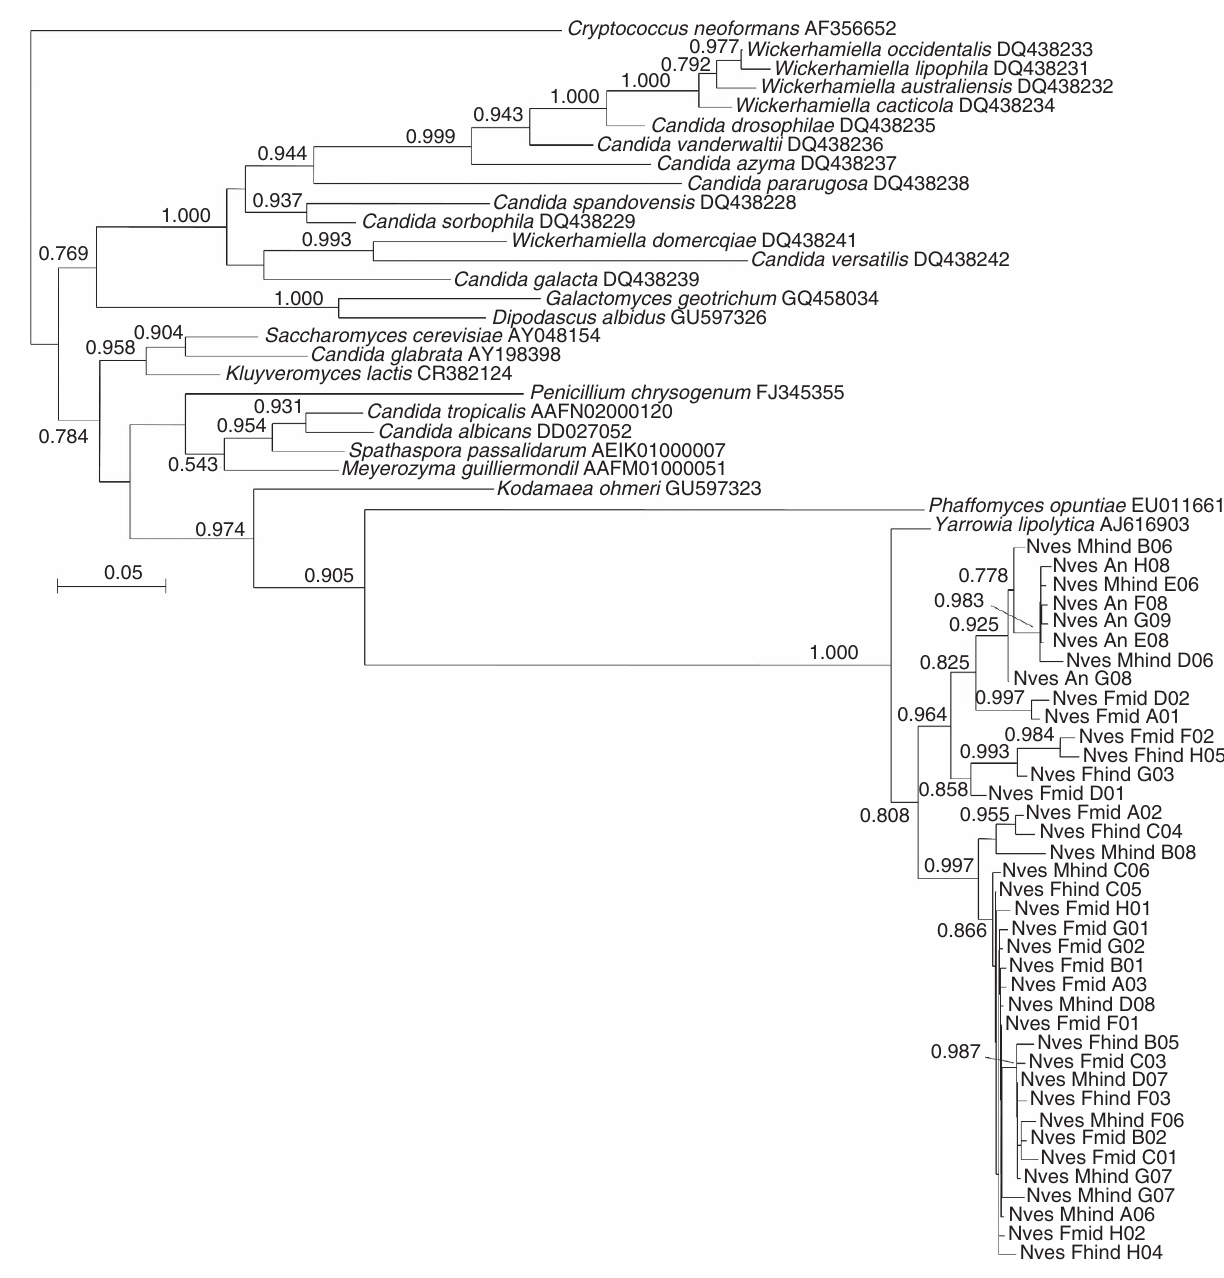
Figure 6 | Phylogenetic affiliation of representative fungal LSU rRNA gene sequences obtained by cloning and sequencing amplicons from adult male and female beetle guts. Sequences likely representing a new yeast species related to Yarrowia lipolytica were abundantly associated with N. vespilloides gut tissues. Sequences were aligned in SINA and ARB, and the phylogeny was reconstructed using